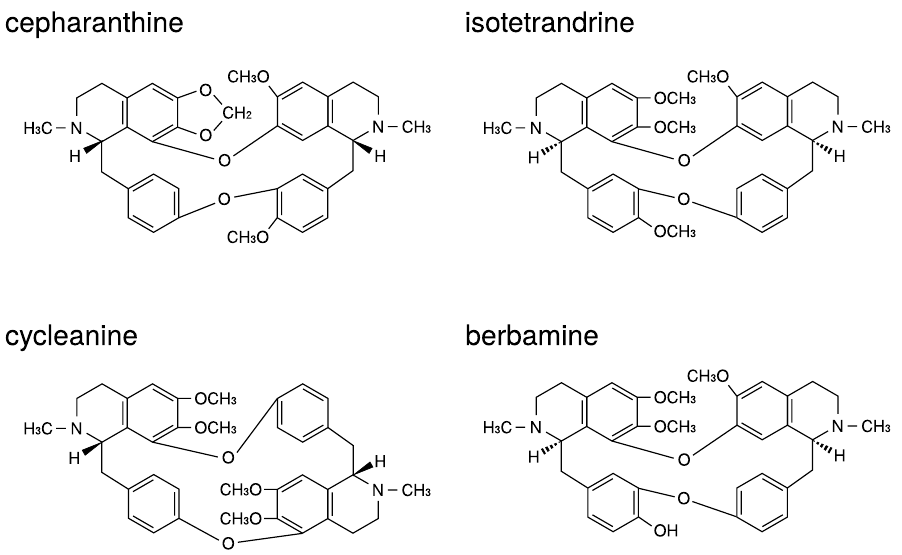
Figure 1. The structures of active ingredients in Cepharanthin R (cid:13)